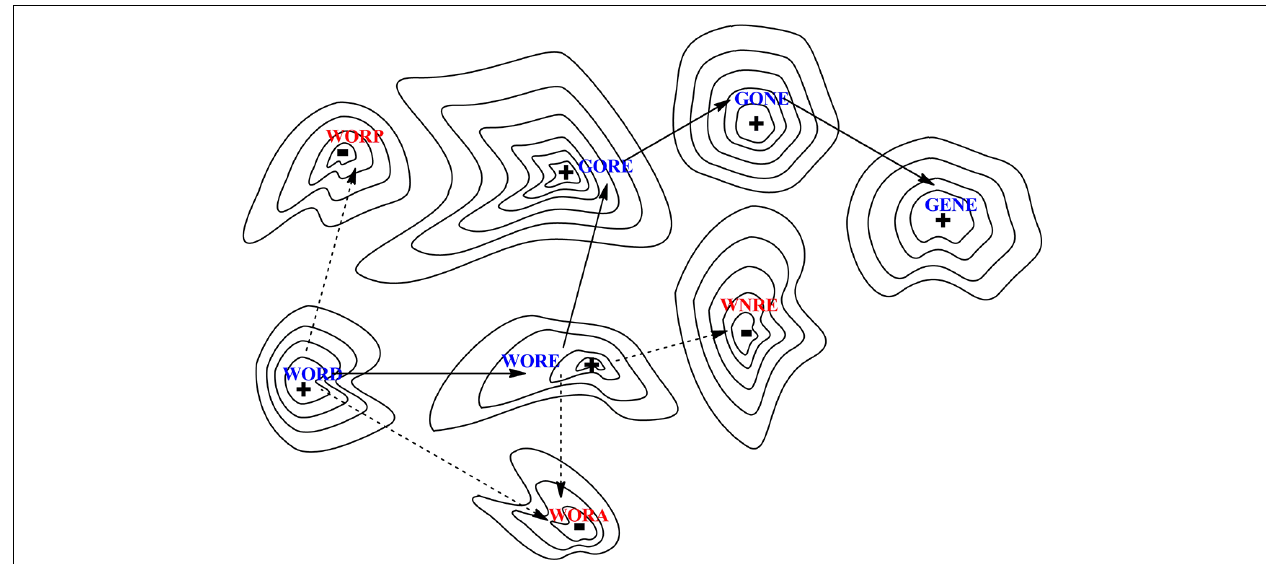
letters (here “word”) must be reached starting from another string (“gene”) via stepwise replacement of single letters, where every intermediate along the path must itself also be a functional word. Solid arrows indicate a path of accepted mutations while dashed arrows illustrate deleterious mutations that produce non-functional